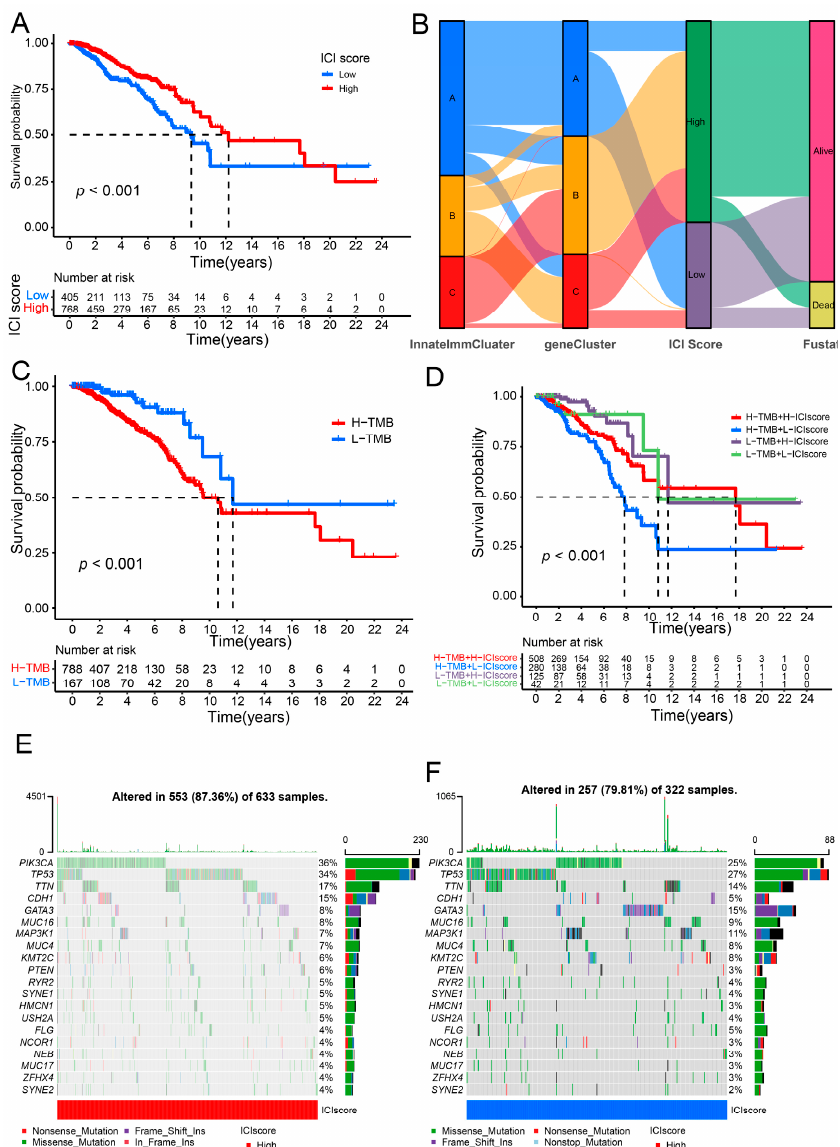
Figure 3. Constructed the ICI score model in breast cancer patients. ( A ) Comparison of the high ICI score level group and the low ICI score level group of overall survival of breast cancer patients through Kaplan–Meier survival analysis. ( B ) Prediction of the connection of innateImmCluster subtype, genecluster subtype, ICI score and the survival status of prognostic in breast cancer patients were shown via sankey plot. ( C ) Analysis of overall survival probability of breast cancer between the high TMB level group and the low TMB level group. ( D ) Combination of the ICI score and TMB level, the overall survival probability of breast cancer prognosis were analyzed. Comparison of the mutation rates of the top 20 genes between the high ICI score of breast cancer ( E ) and the low ICI score of breast cancer ( F ) through maftools.